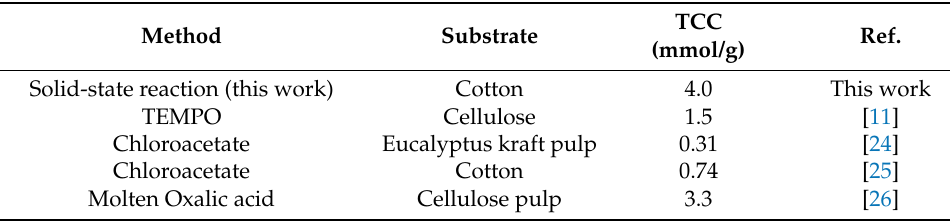
Table 3. Comparison of TCC values obtained by different reported